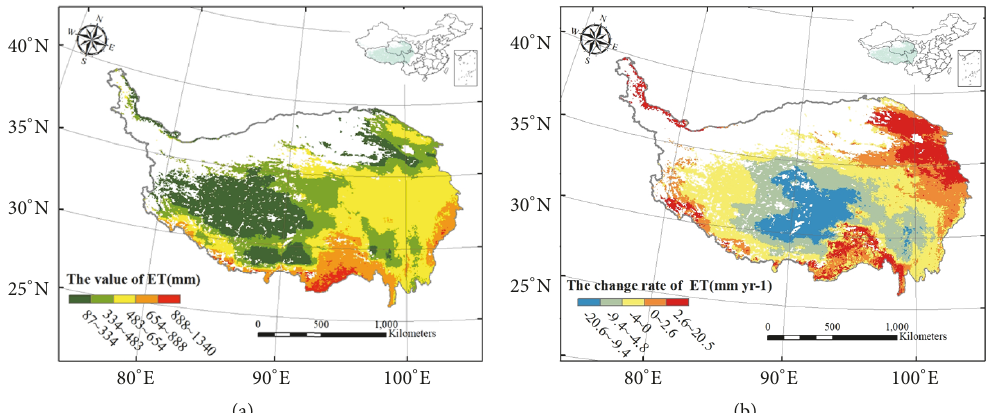
Figure 3: Spatial patterns and dynamics of ET across the Tibetan Plateau. Graphs (a) and (b) represent distribution and variation of ET,